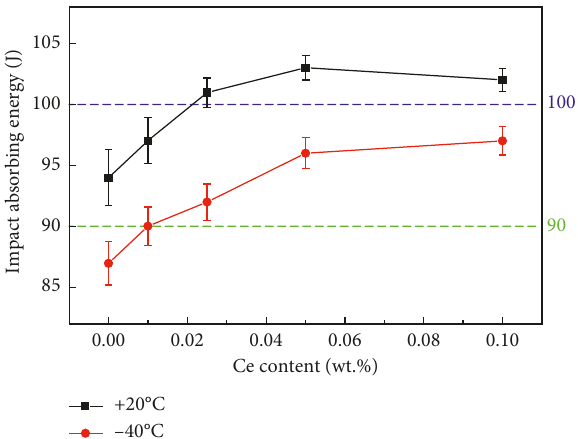
Figure 8: The evolutions of impact absorbing energy with the rare earth Ce content under different